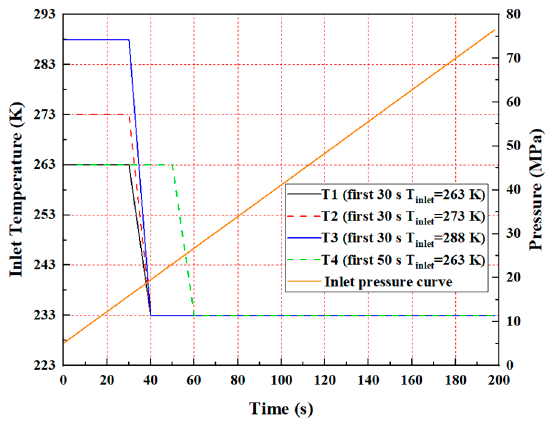
Figure 18. Four pre-cooling patterns from the cylinders.